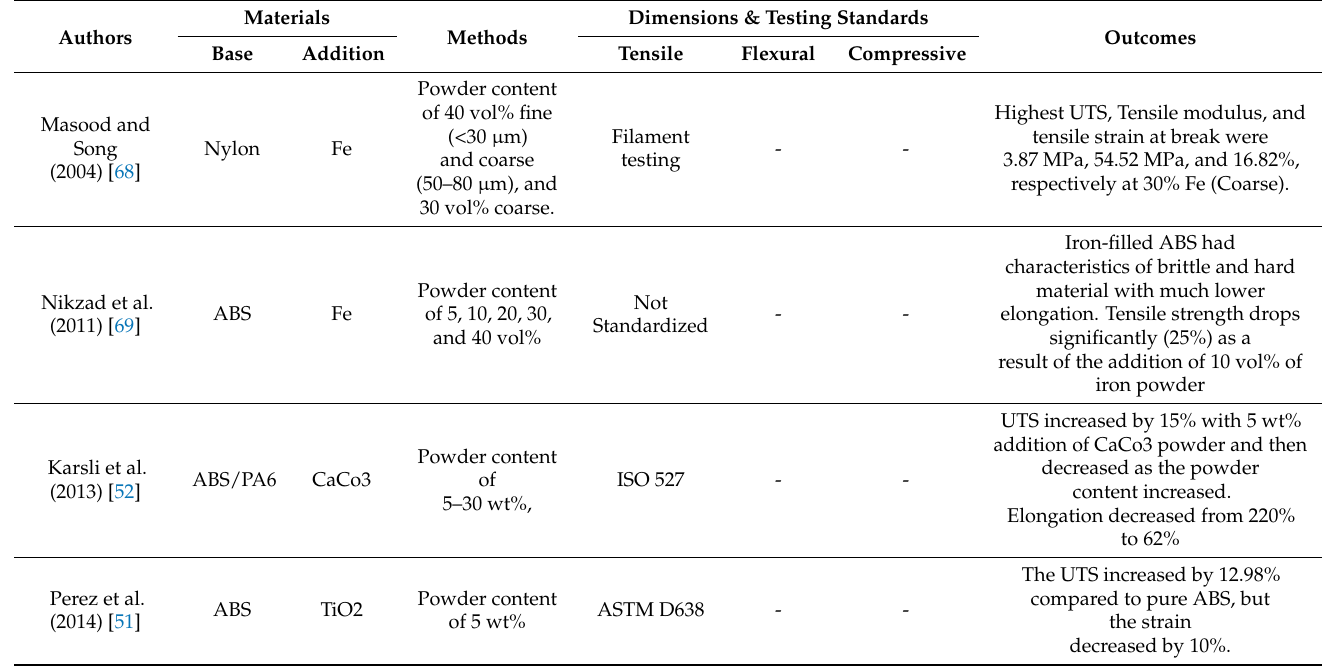
Figure 8. ( a ) Minimum gap in CFR, ( b ) return radius, and ( c ) fiber breakage during returning. Reprinted with permission from [59]. Copyright 2019, Elsevier. Table 4. Research on Powder Addition